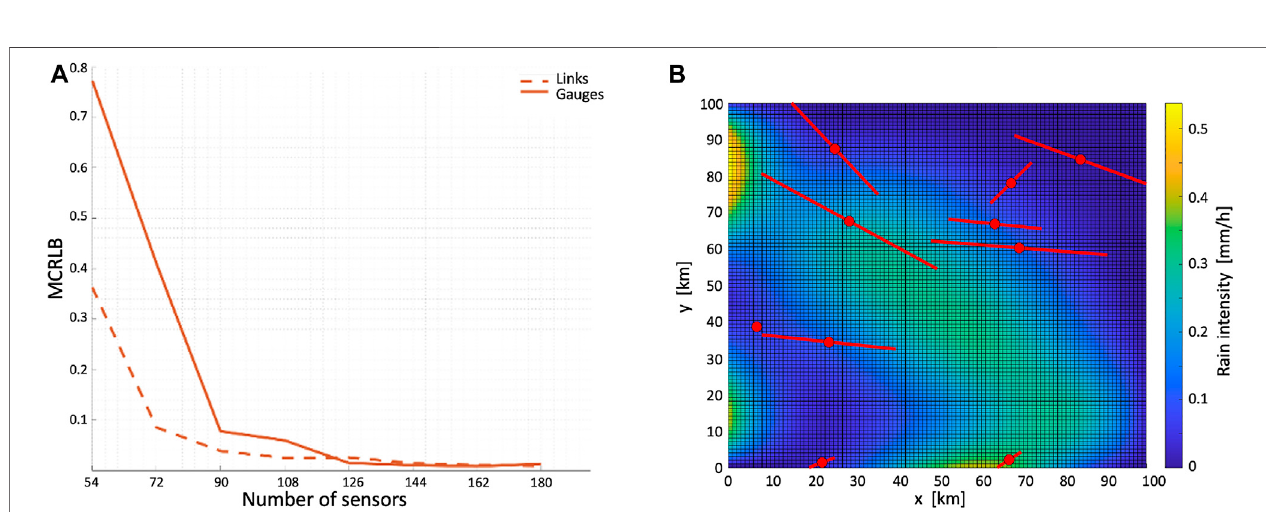
FIGURE 8 | (A) : Trace of the mean Cramér – Rao lower bound for 3 rd -order B-spline with CMLs (dashed line) and RGs (solid line) as a function of the number of sensors in the given area (e.g., density). (B) : An assumed network of CMLs and the corresponding RGs with a 2D map of the simulated rain fi eld.